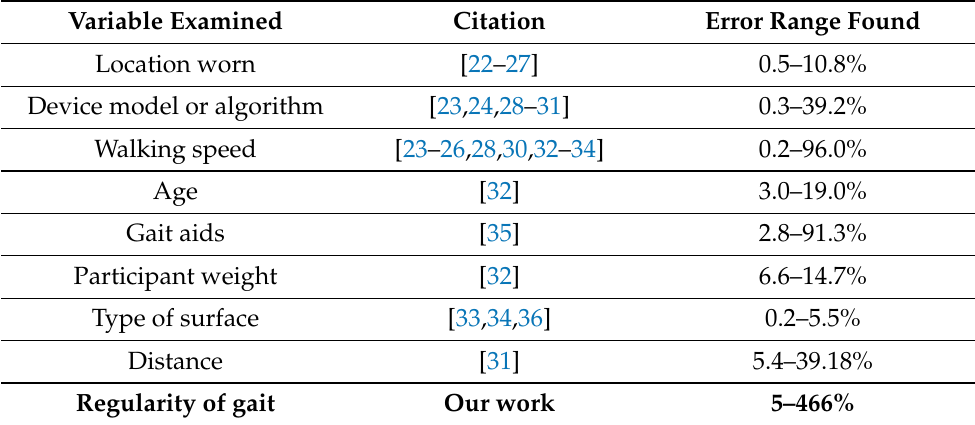
Table 1. Related works evaluating pedometer algorithm accuracy categorized by variable examined. The extent to which the variable affects accuracy is reported. Prior works have not examined regularity of gait as a variable, however this work finds that it contributes significantly to